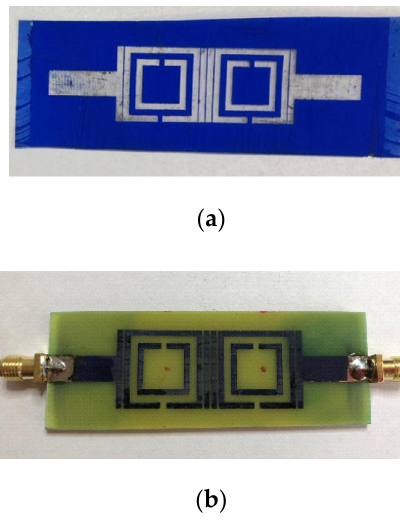
Figure 9. Implementation of the sensor: ( a ) Coated Mylar (Polyester) foil base material; ( b ) the sensor implemented on a FR-4 substrate, with 1.6 mm, with Cooper metallization on both sides; ( c ) measurement setup.